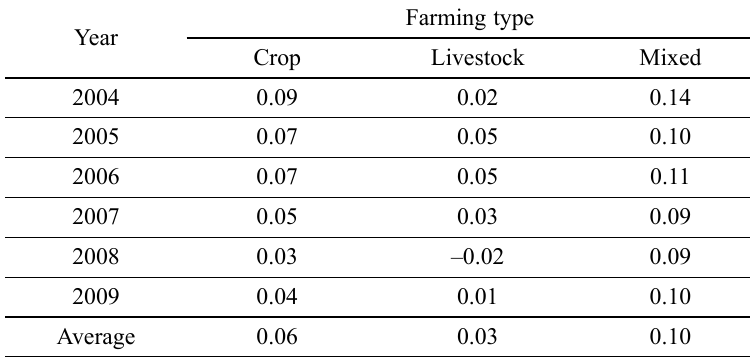
Table 5. Output elasticity with respect to utilized agricultural area,